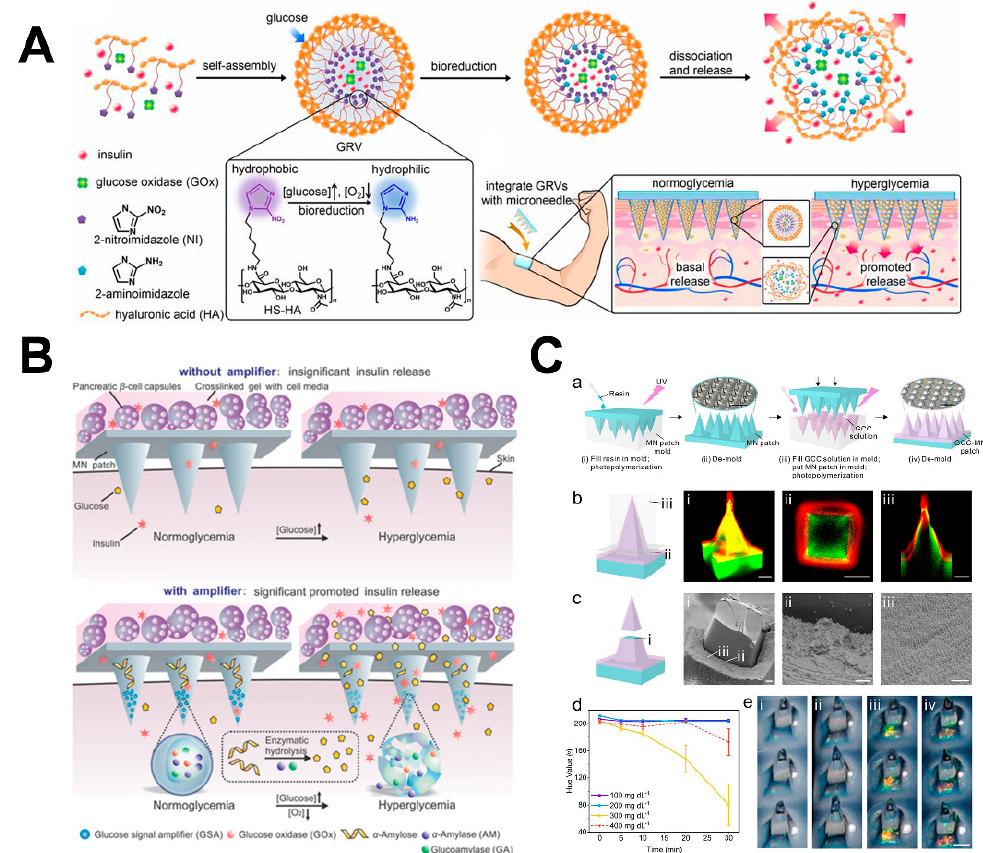
Figure 10. Illustration of microneedles for the diagnosis and therapy of diabetes. ( A ) Illustration of an insulin-releasing microneedle to detect glucose level. ( B ) Schematic diagram of a microneedle that can be used as a glucose signal amplifier (GSA). ( C ) Schematic diagram of painless patch for detecting blood sugar by colorimetry. (Images were reproduced with permission from [23,90,91]).